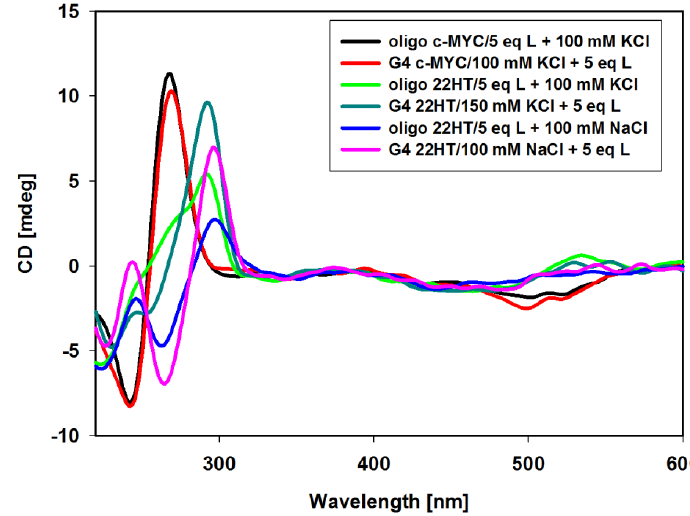
Figure 9. CD spectra of G-quadruplexes formed by 22HT and c-MYC oligonucleotides upon different addition order of ligand 3 and salt. Conditions: 5 µM 22HT or c-MYC, 25 µM ligand 3 , 100 mM KCl or NaCl, Tris-HCl buffer (10 mM, pH 7.2).